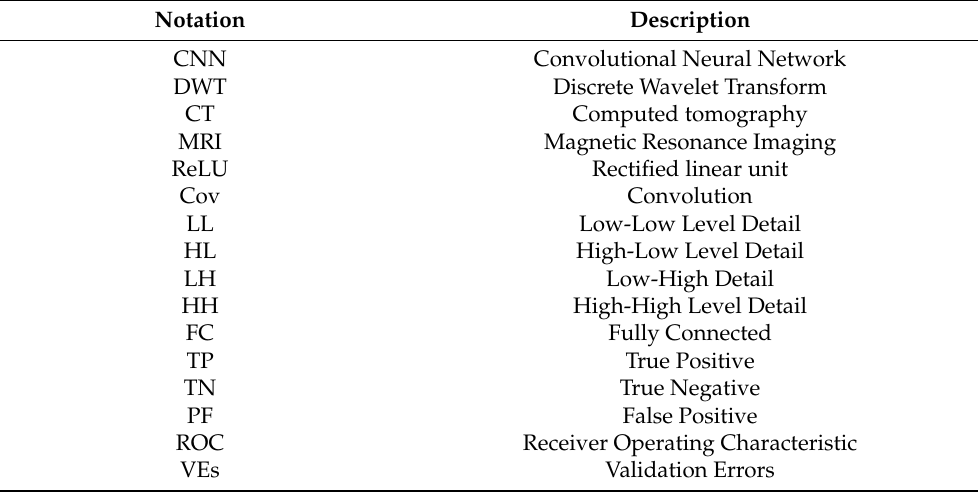
Table 1. Notations with the